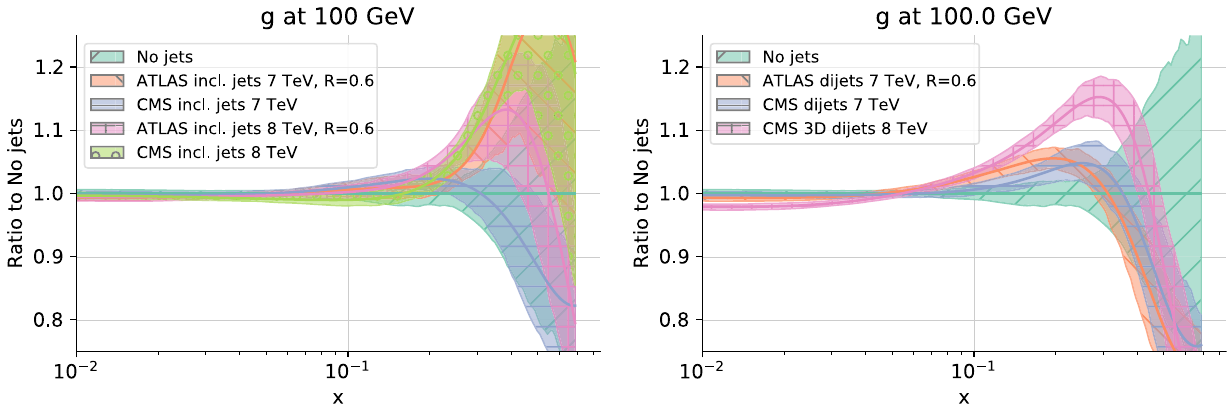
Fig. 15 The gluon PDF, at Q = 100 GeV, for some of the fits of Table 17: the baseline variant with no jets, and the fits with each of the single-inclusive jet data (left) or each of the dijet data (right). Results are shown normalized to the central value of the no jets variant